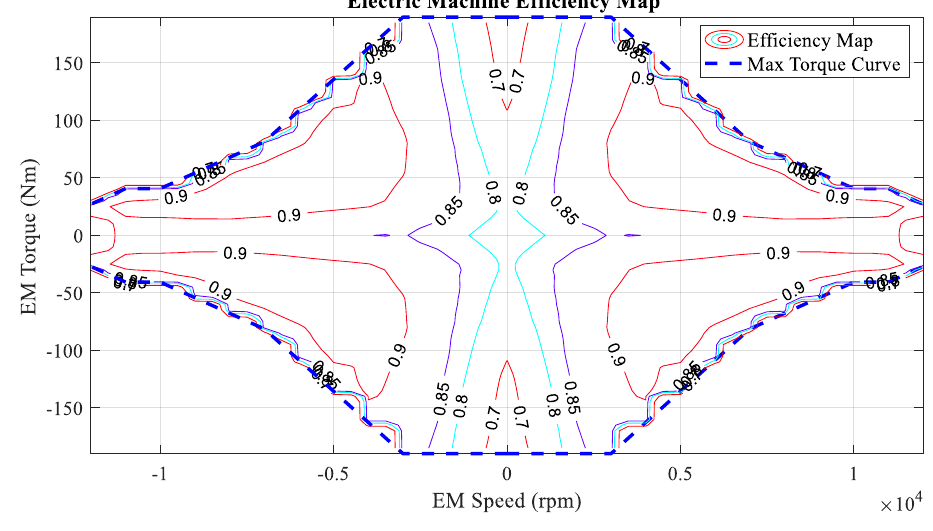
Figure 6. The efficiency of motor/generator.